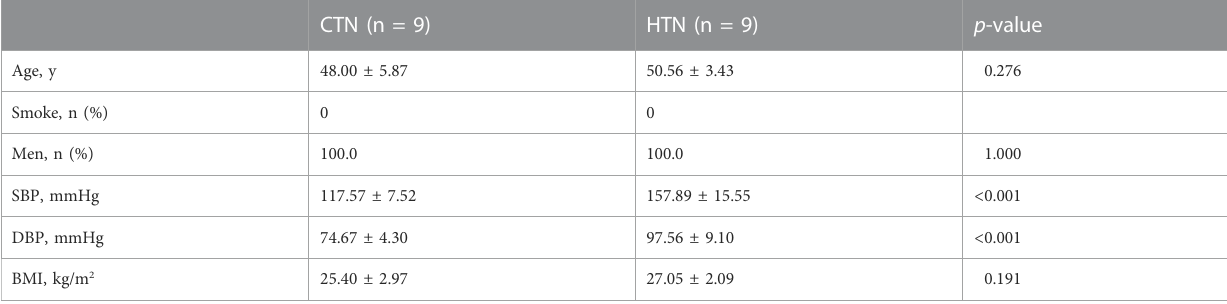
TABLE 3 Basic characteristics of normotensive controls and hypertensive patients for CyTOF mass